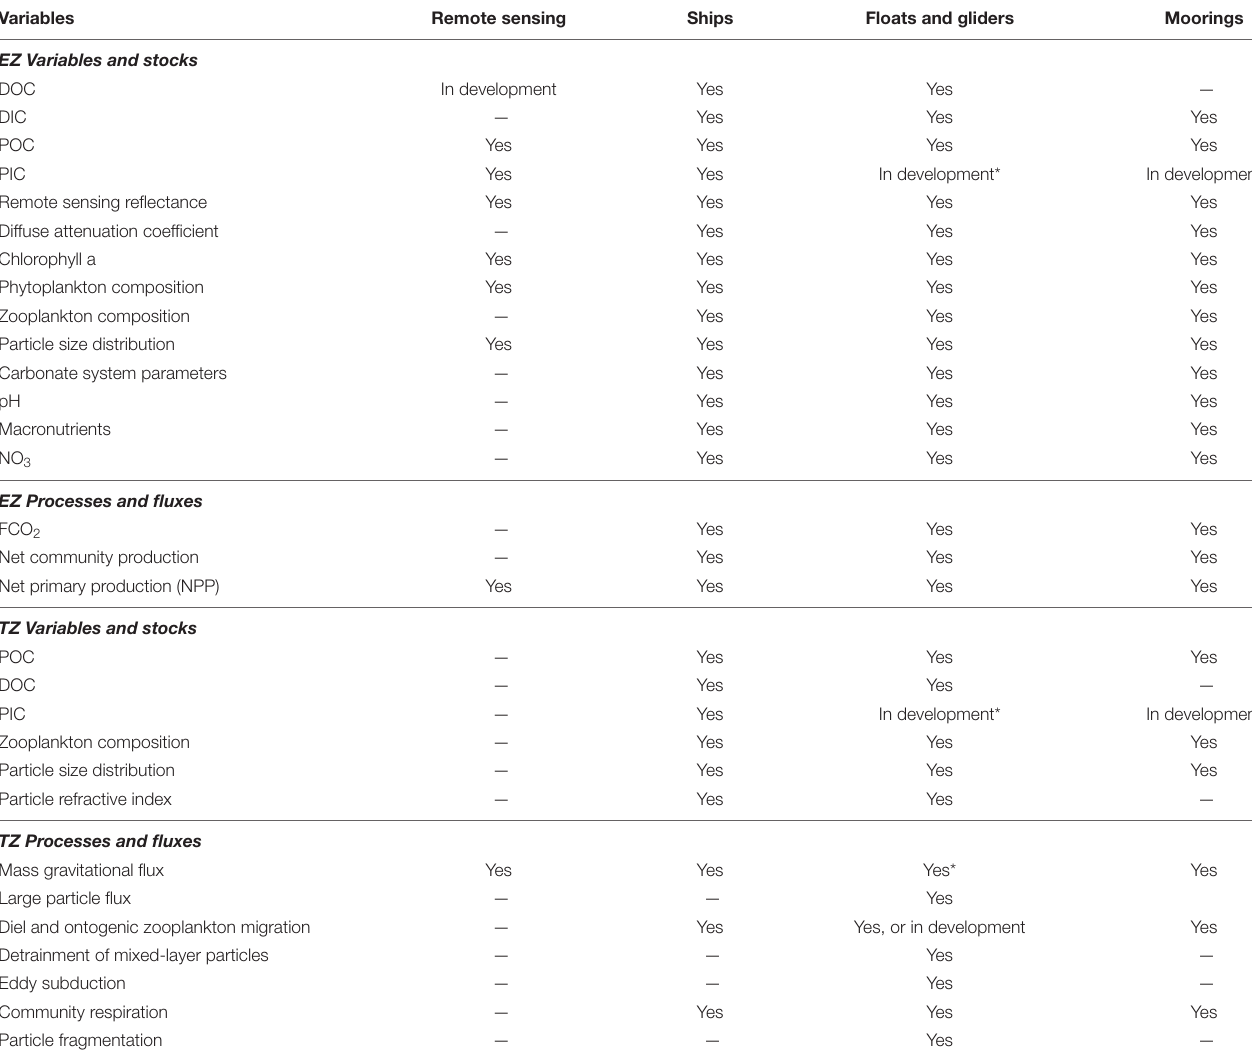
TABLE 1 | Availability of methods and sensors for measuring or estimating biogeochemically relevant variables, stocks, processes and fluxes in the EZ and TZ potentially involved in the BCPs using different sampling platforms.